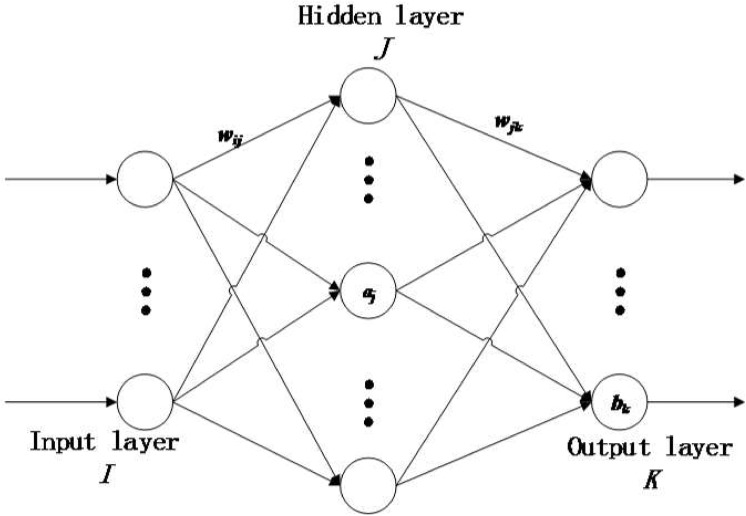
BP neural network.